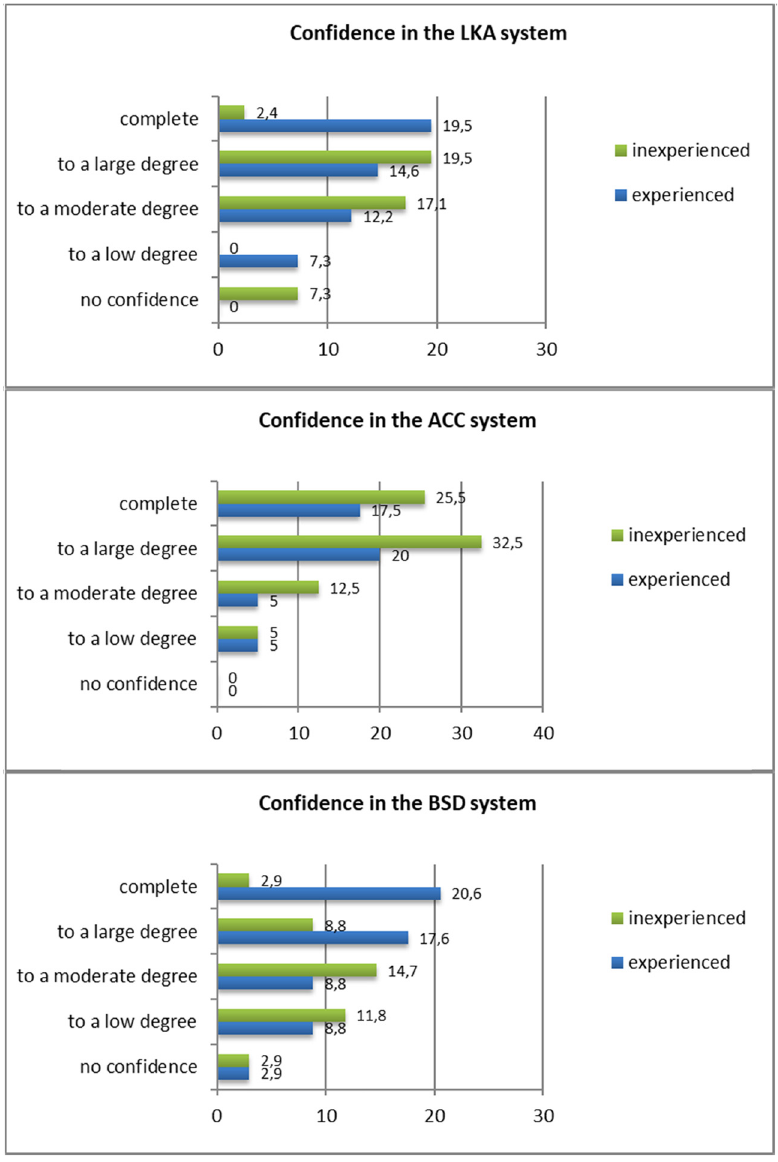
Figure 5: Con fi dence in driver - assistance systems of experienced and inexperienced drivers ( % ) . Source: author ’ s own